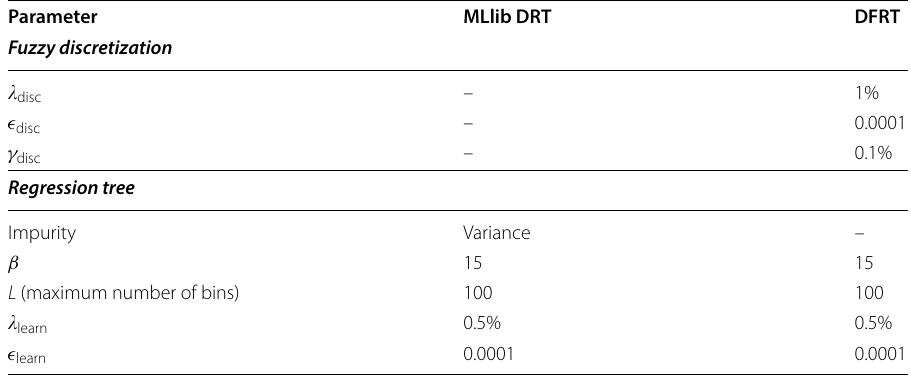
Table 2 Parameters for the MLlib DRT and the DFRT